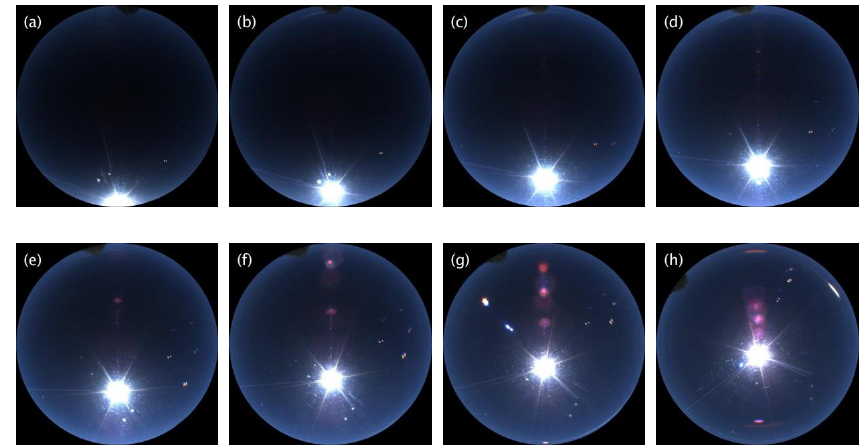
Figure 4. Several typical clear sky background images captured on 11 June 2013. The solar elevation angles of (a) to (h) range from 10 to 80 ◦ at intervals of 10 ◦ .